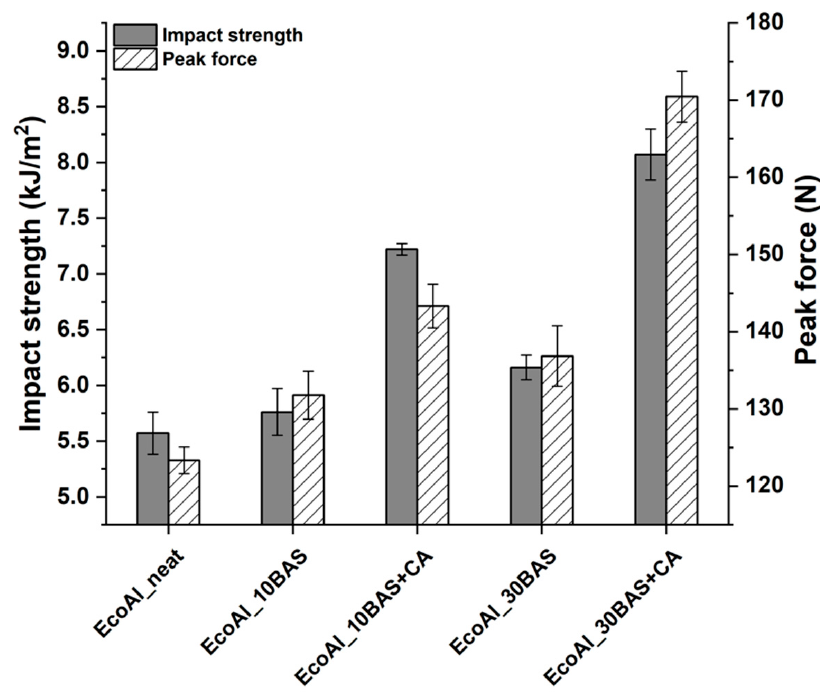
Figure 7. Charpy impact test results of EcoAllene-based composites.